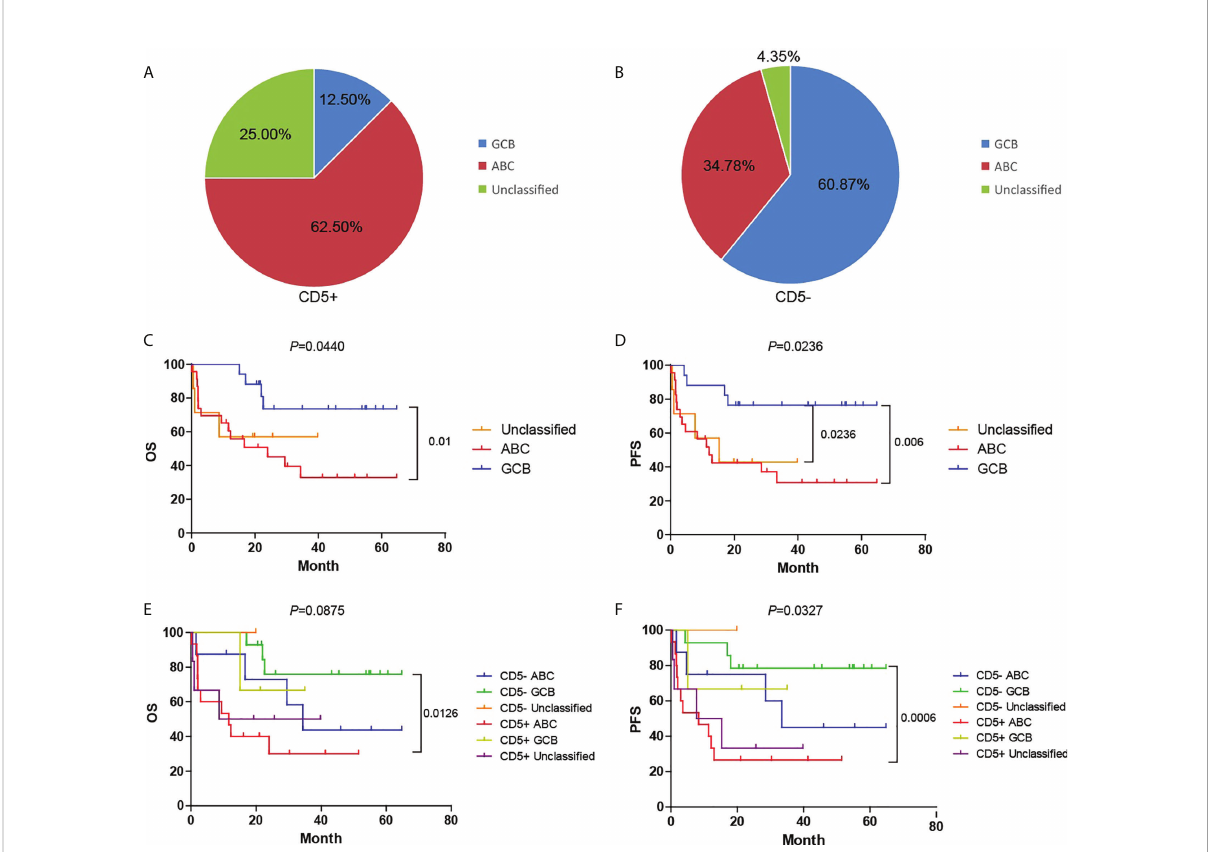
FIGURE 4 COO assessment of CD5+ and CD5- DLBCL by Lymph2Cx assay on the NanoString platform. (A, B) The proportion of cases classi fi ed as GCB, ABC, or unclassi fi ed in the CD5+ and CD5- groups. (C, D) Kaplan – Meier plot of the OS and PFS among GCB, ABC, and unclassi fi ed subtypes. (E, F) Kaplan – Meier plot of OS and PFS among GCB, ABC, and unclassi fi ed subtypes in CD5- and CD5+ groups separately. GCB, germinal center B cell – like; ABC, activated B